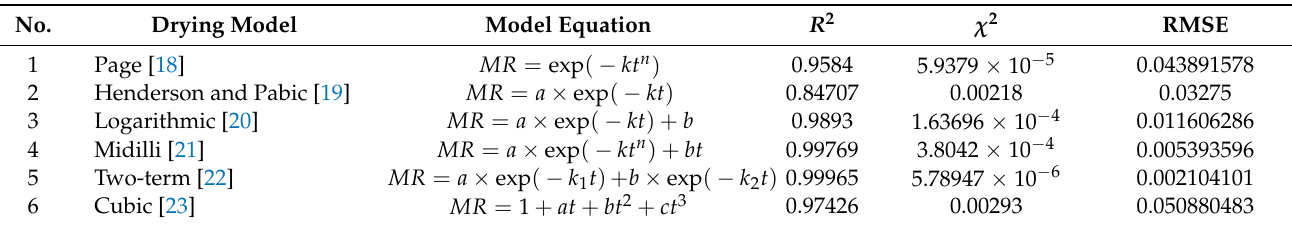
Table 4. Mathematical models of common drying